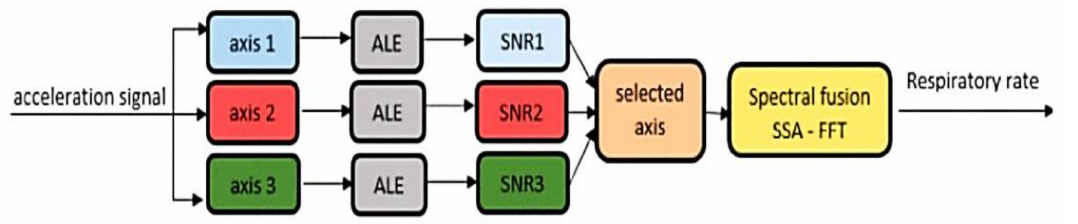
Figure 15. Block diagrams of the algorithm for determining the RR from accelerometry